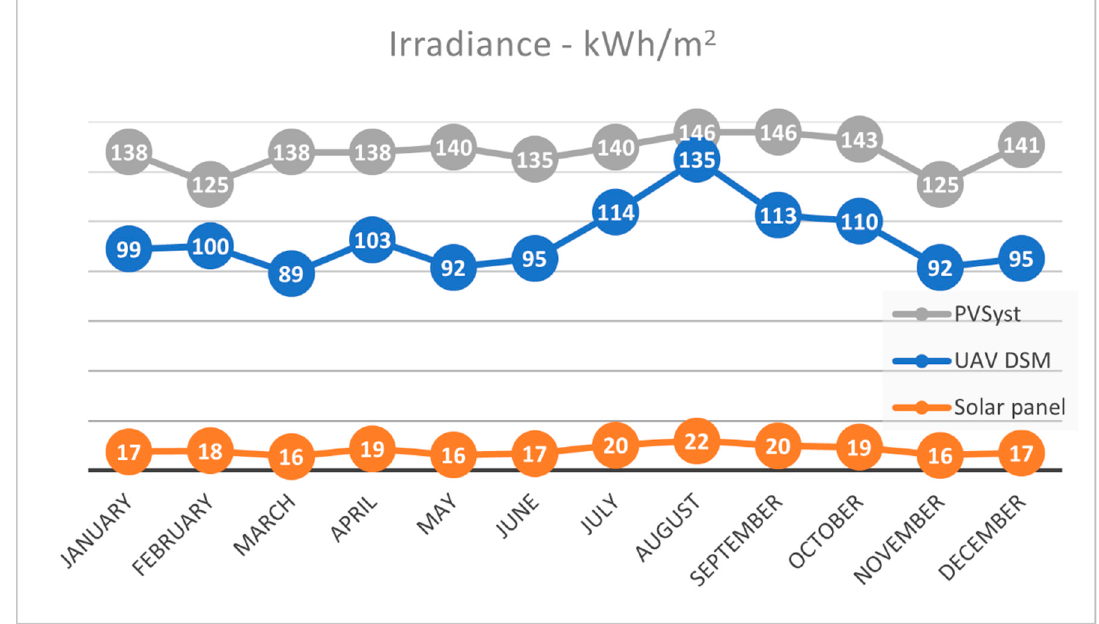
Figure 15. Comparative solar irradiance in 2019, PVsyst data, UAV-DSM data and solar panels.